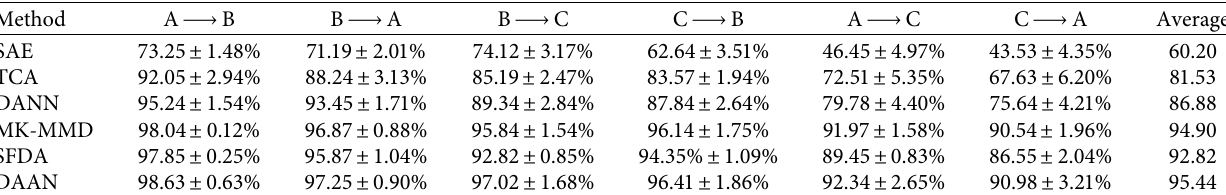
Table 1: Classification results in Experiment